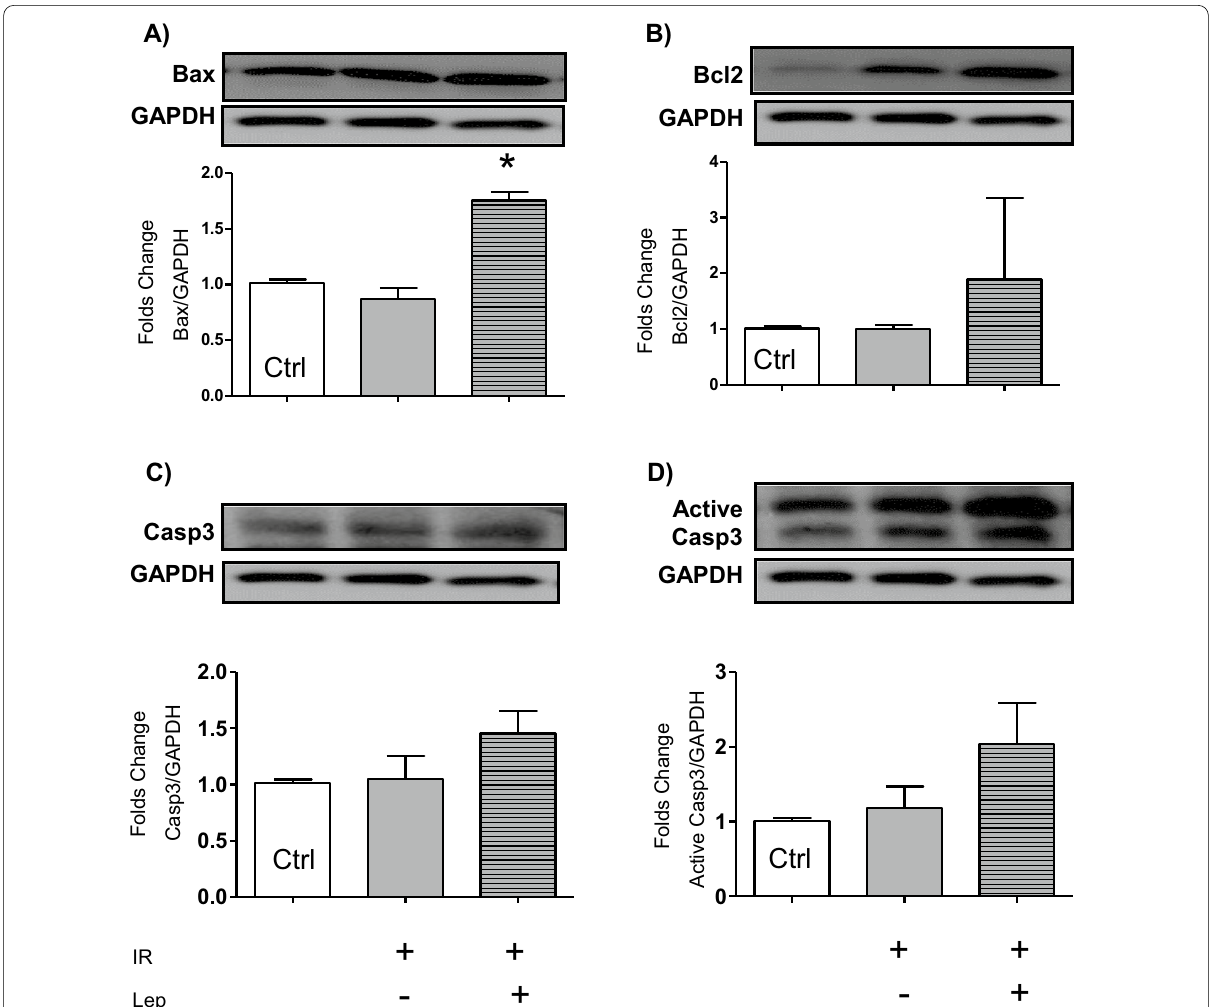
Fig. 4 Effect of leptin on the levels of apoptosis‑associated proteins Bax, Bcl‑2, and caspase 3 in heart homogenates. A Bax content; bars represent the median SEM of three independent preparations. B Bcl‑2 content. C Caspase 3 and D activated caspase 3 content; values indicate the ± mean SEM, n 3; * p < 0.05. GAPDH was used as loading control. Ctrl control without ischemia; IR ischemia–reperfusion; Lep ± =